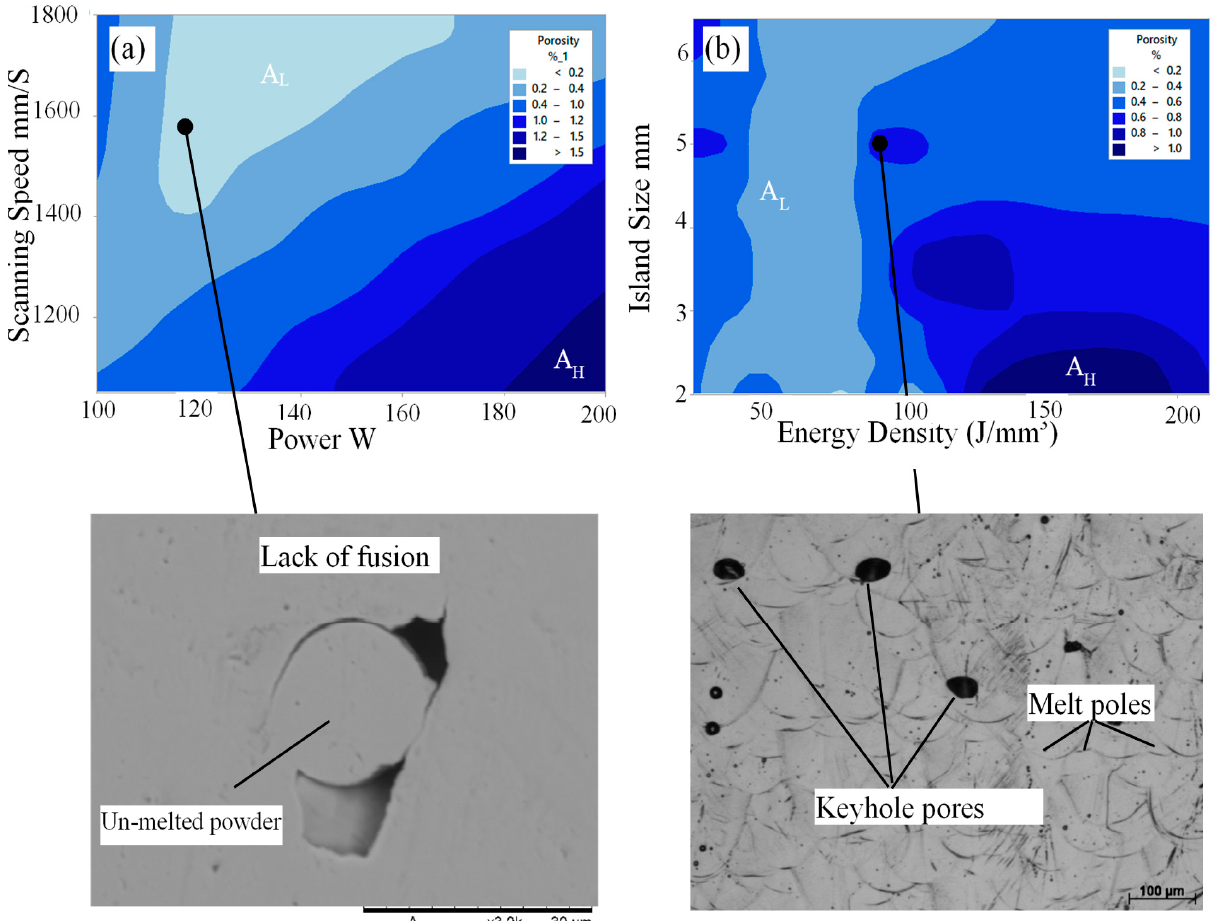
Figure 8. The predicted contours distribution of the porosity of Ti-6Al-2Sn-4Zr-6Mo alloy with respect to the process parameters and their corresponding porosity defects ( a ) effect of power and scanning speed, ( b ) effect of energy density and island size).